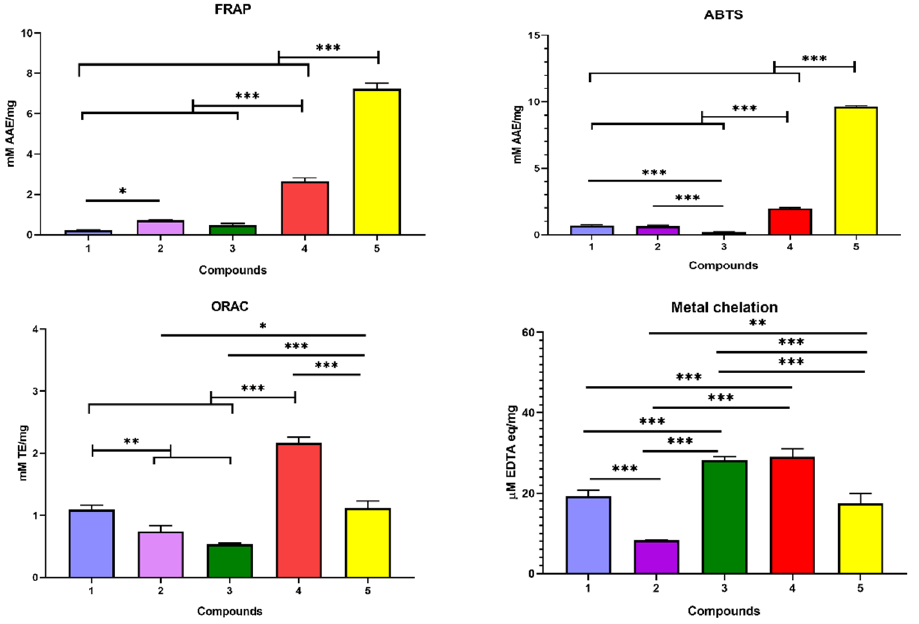
Figure 5. Antioxidant activity (ABTS, FRAP, ORAC and metal chelation) of isolated compounds 1 – 5 from C. oblongifolia . *** Significantly different at p < 0.0001, ** significantly different at p < 0.001, * significantly different at p < 0.05.